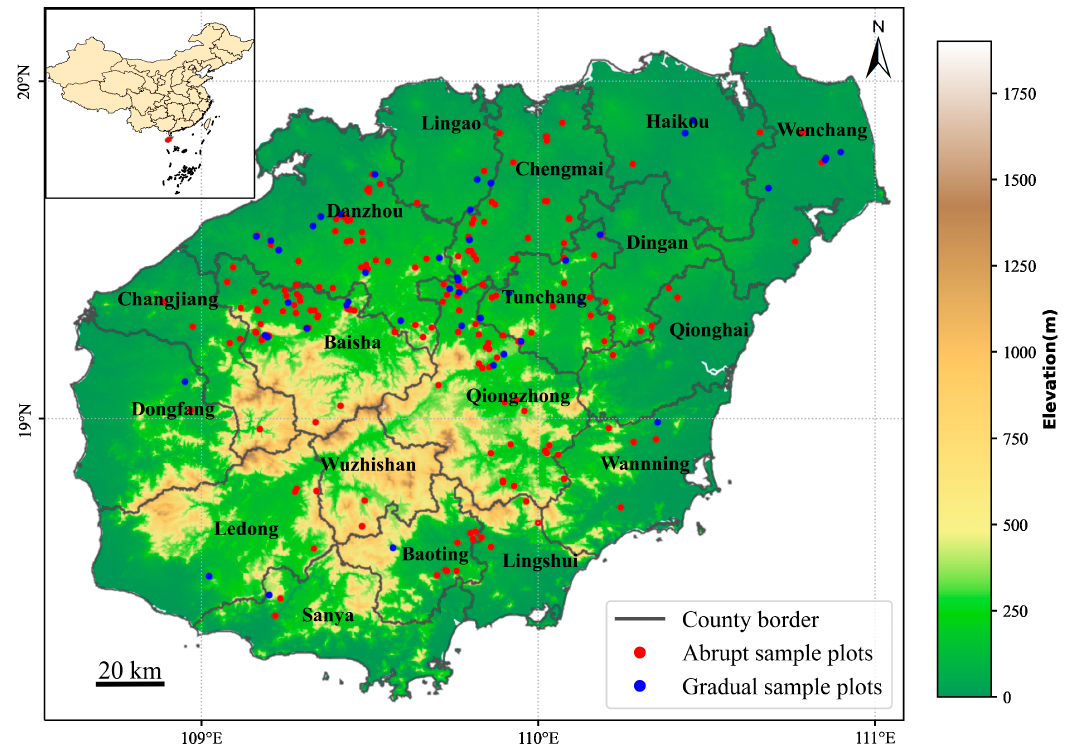
Figure 1. Spatial distribution map of topographic and ground samples on Hainan Island.